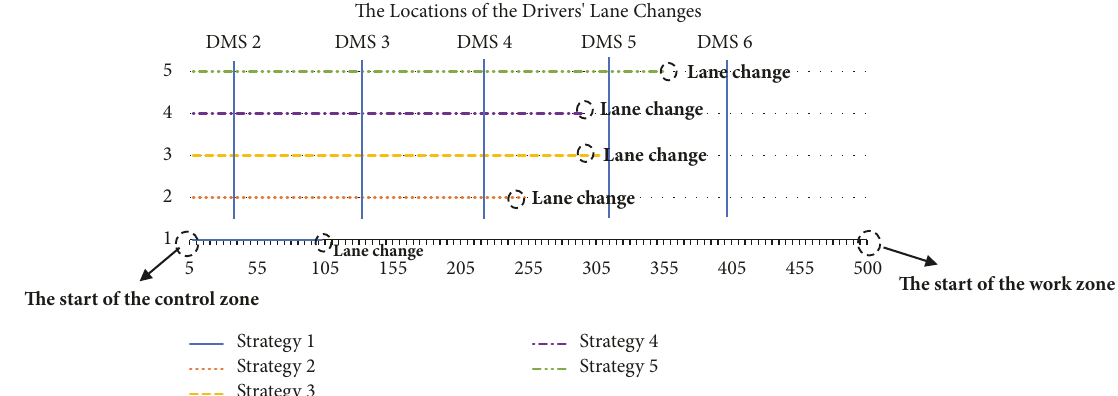
Figure 4: Locations of drivers’ lane